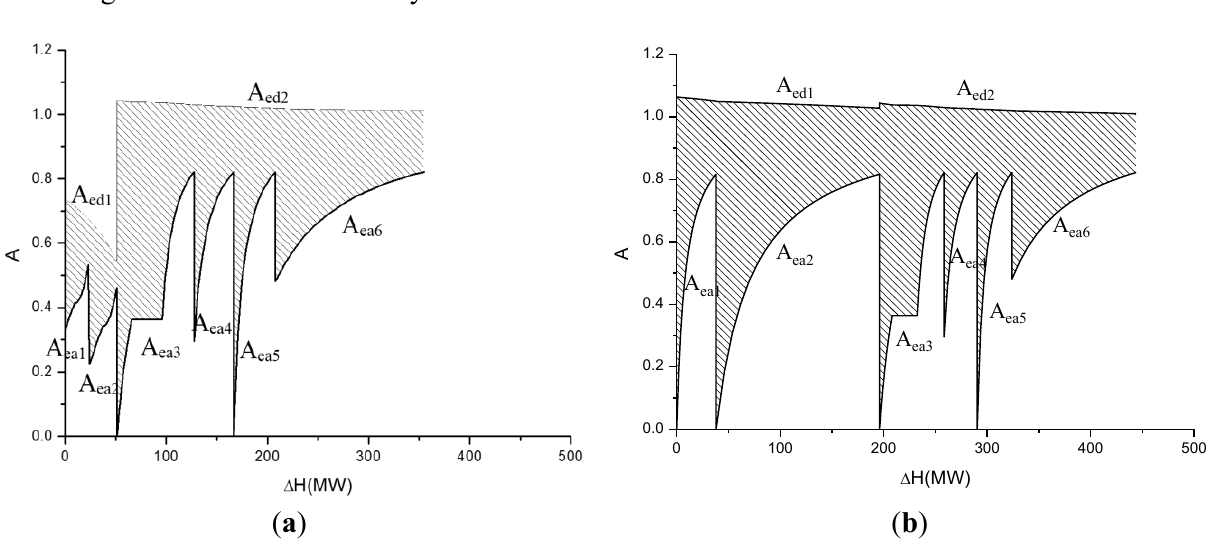
Figure 4. ( a ) EUD for combustion and gasification in the MES; ( b ) EUD for combustion and gasification in reference